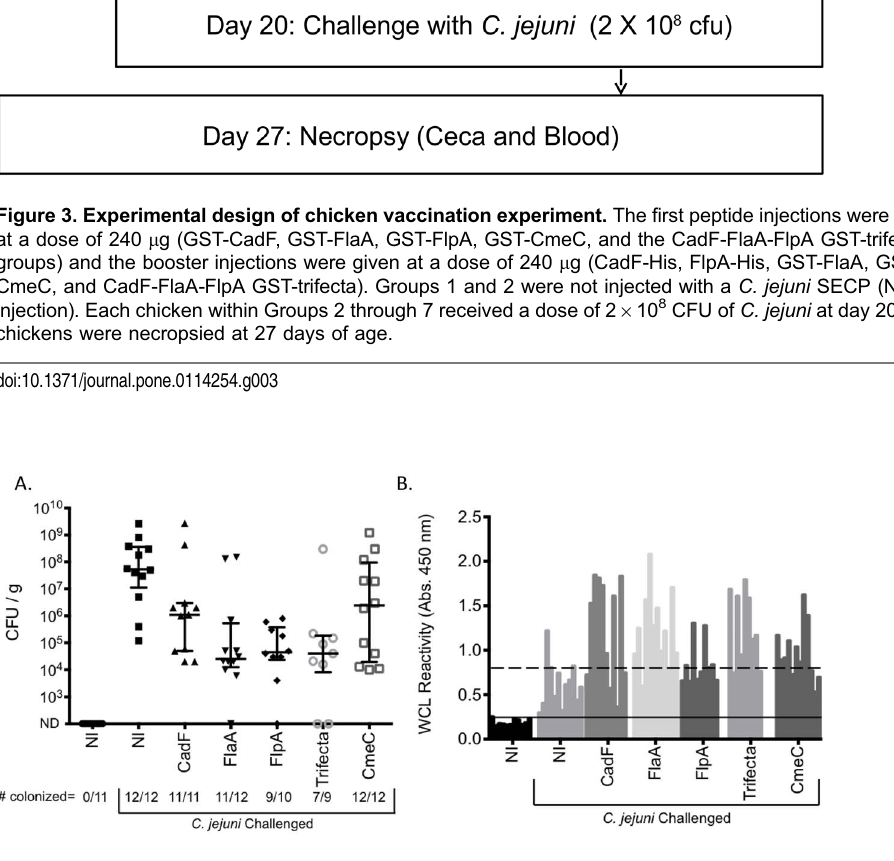
Figure 4. Vaccination with CadF, FlaA, FlpA, and trifecta peptides reduces C. jejuni colonization. Panel A: The number of CFU of C. jejuni was determined by serially plating diluted cecal contents on Campy-Cefex plates. The median level of colonization and interquartile range are shown for each group. The number of birds colonized in each group is shown below the graph. NI 5 no injection. ND 5 not detected; limit of detection is 10 3 CFU/gram of cecal contents. Panel B: Sera was isolated from blood collected from the chickens at the time of necropsy and examined via ELISA using microtiter plates coated with a C. jejuni whole-cell lysate. Chicken IgY bound to the coated wells was detected with a rabbit anti-chicken IgY antibody conjugated to HRP. 95% confidence intervals were calculated based on the level of sera reactivity in the non-vaccinated, unchallenged group (solid line) and non-vaccinated, non-challenged groups of chickens (dashed